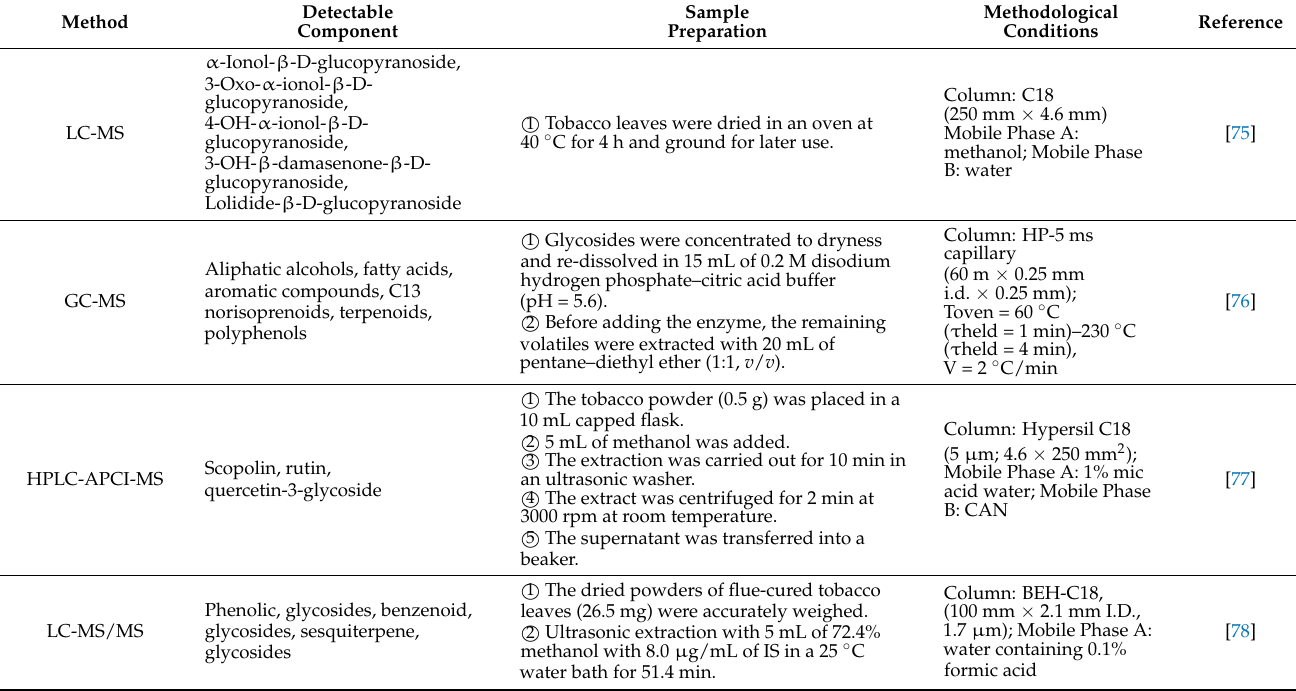
Table 4. Methods for determining glycosides in tobacco